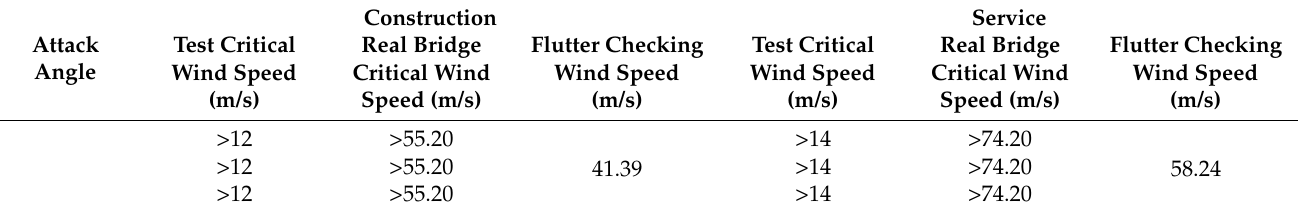
Table 4. Flutter critical wind speed test results.